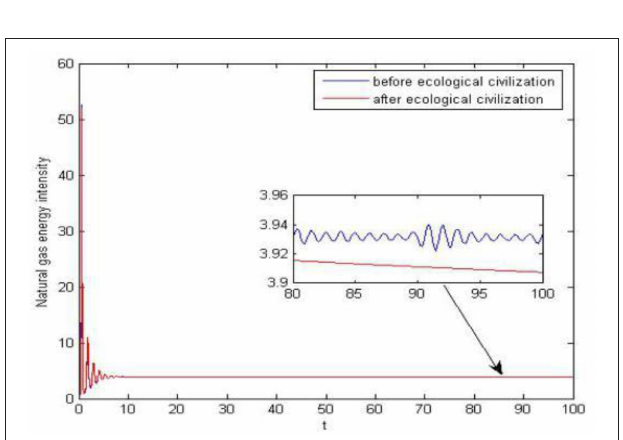
FIGURE 5 | Natural gas energy ecological civilization ecological construction intensity